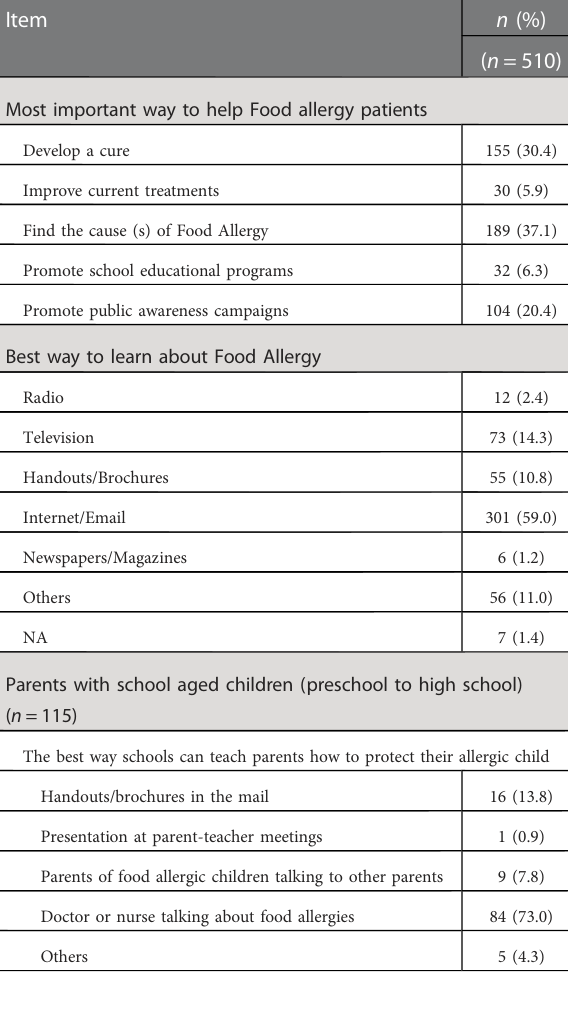
TABLE 5 Attitudes and beliefs